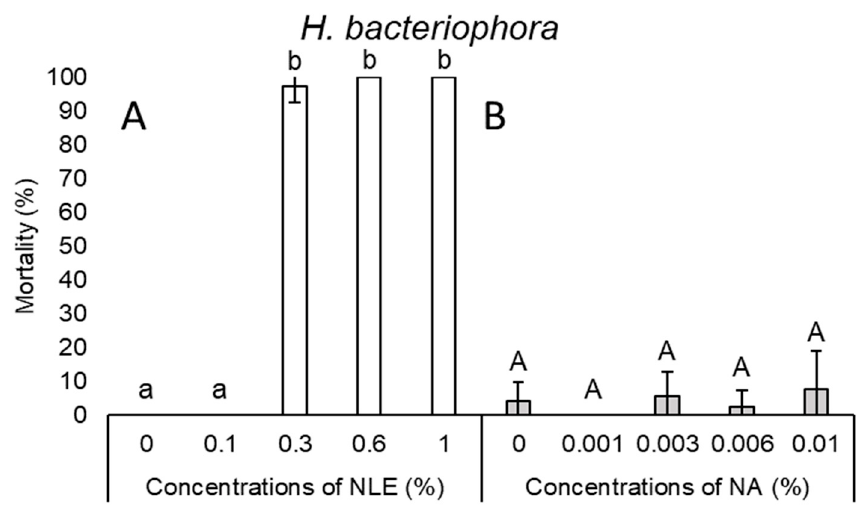
Figure 1. Mortality after 24-h exposure time of Heterorhabditis bacteriophora juveniles of 0.1%, 0.3%, 0.6%, and 1% neem leaf extract (NLE) ( A ) and 0.001%, 0.003%, 0.006%, and 0.01% of NeemAzal-T/S (NA) ( B ). (One-way ANOVA, Mann–Whitney U test; the same letters indicate no significant difference at p < 0.05 level) .